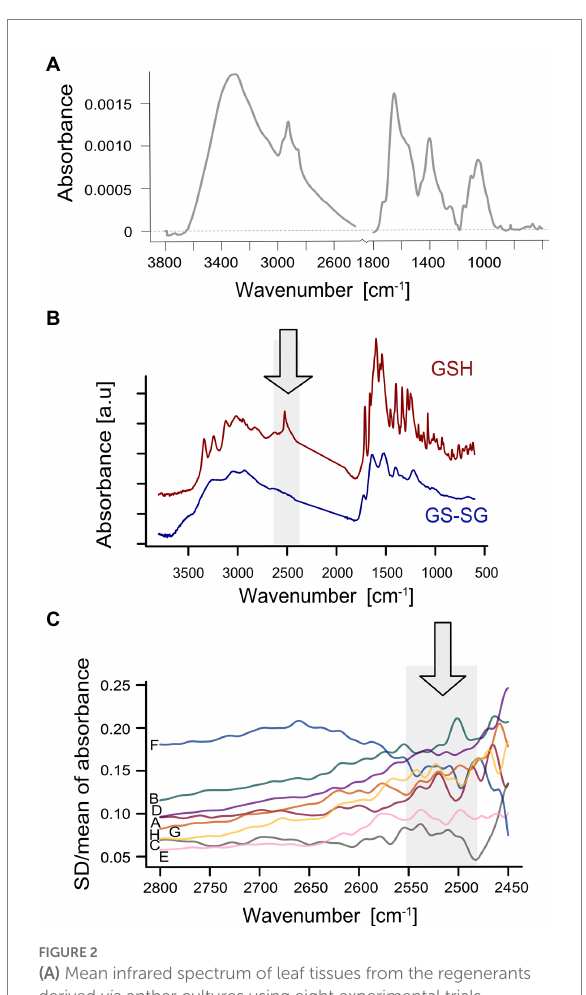
FIGURE 2 (A) Mean infrared spectrum of leaf tissues from the regenerants derived via anther cultures using eight experimental trials. (B) FTIR spectrum of glutathione in reduced (red) and oxidized form (blue). (C) The SD to mean ratio of absorbance for particular trails (labeled with letters).